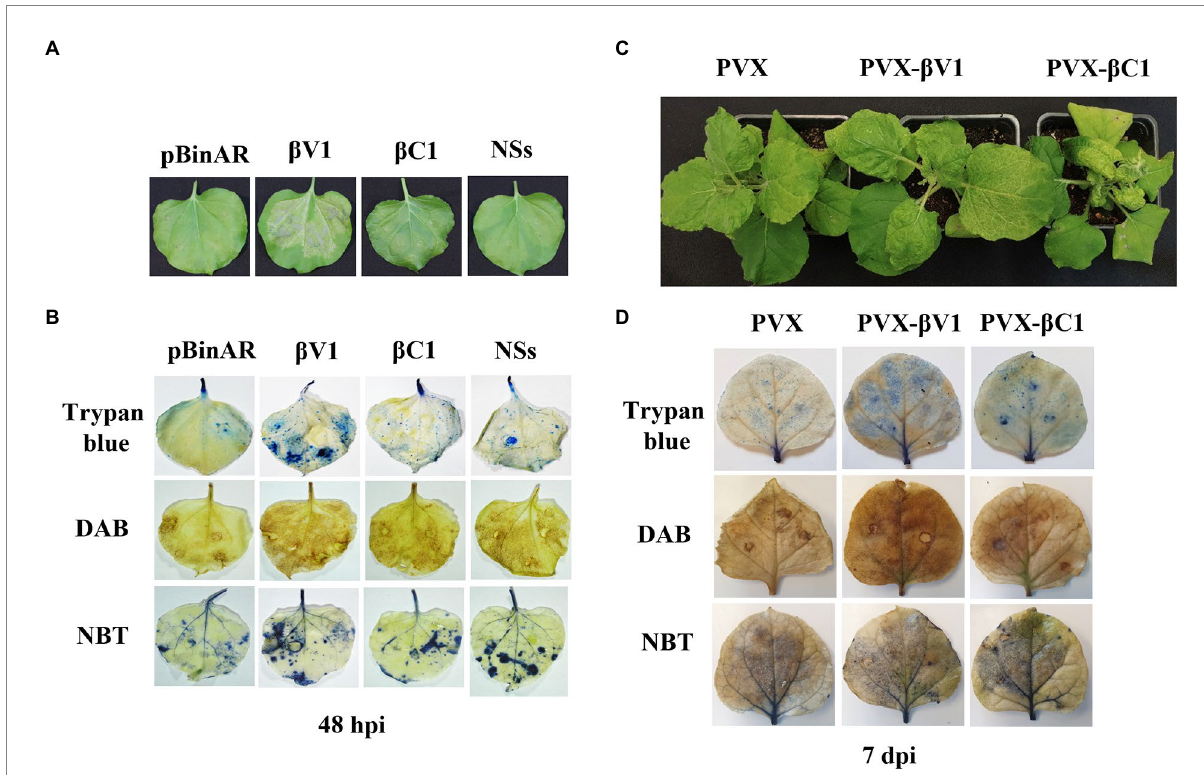
FIGURE 2 β V1 protein acts as inducer of HR response. (A) Cell death observed after 48 h post infiltration of pBinAR- β V1 and pBinAR- β C1 constructs in N. benthamiana . (B) Photographed infected leaves stained with DAB, NBT, and trypan blue showing accumulation of ROS generation and associated with cell death. (C) Symptoms on N. benthamiana plants infected with PVX, PVX- β V1, and PVX- β C1 at 10 dpi. (D) Photographed PVX constructs infiltrated leaf pictures stained with DAB, NBT, and trypan blue at 7